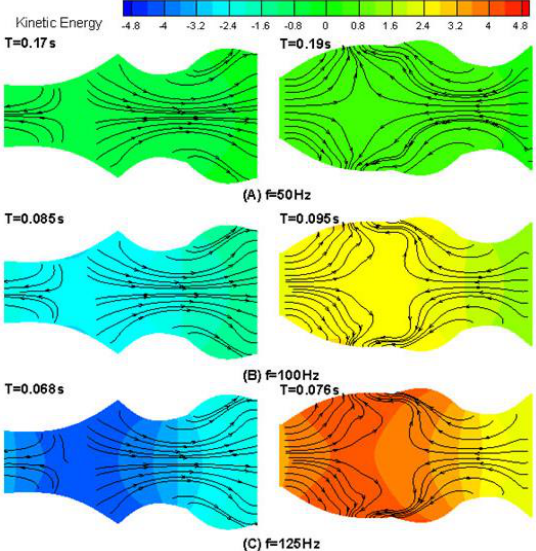
Figure 4. Fluid pumping through the device—instantaneous kinetic energy contours and streamlines in one period with different frequencies. ( A ) f = 50 Hz; ( B ) f = 100 Hz; ( C ) f = 125 Hz.